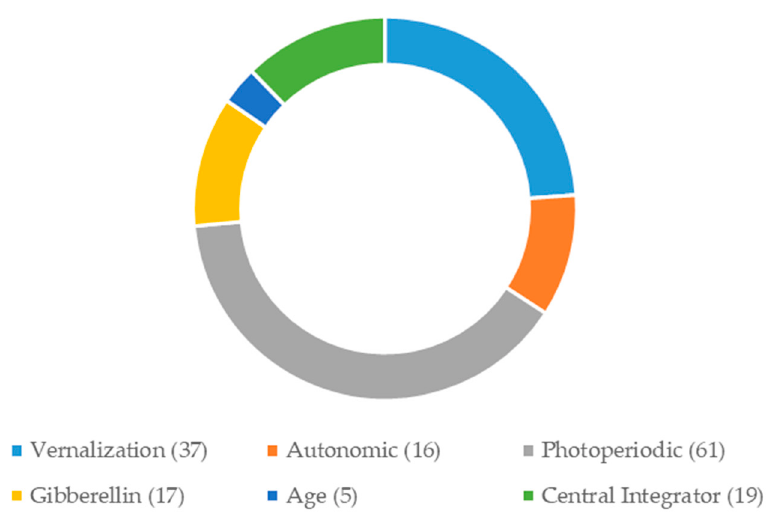
Figure 3. The number of candidate genes involved in six flowering regulatory pathways.